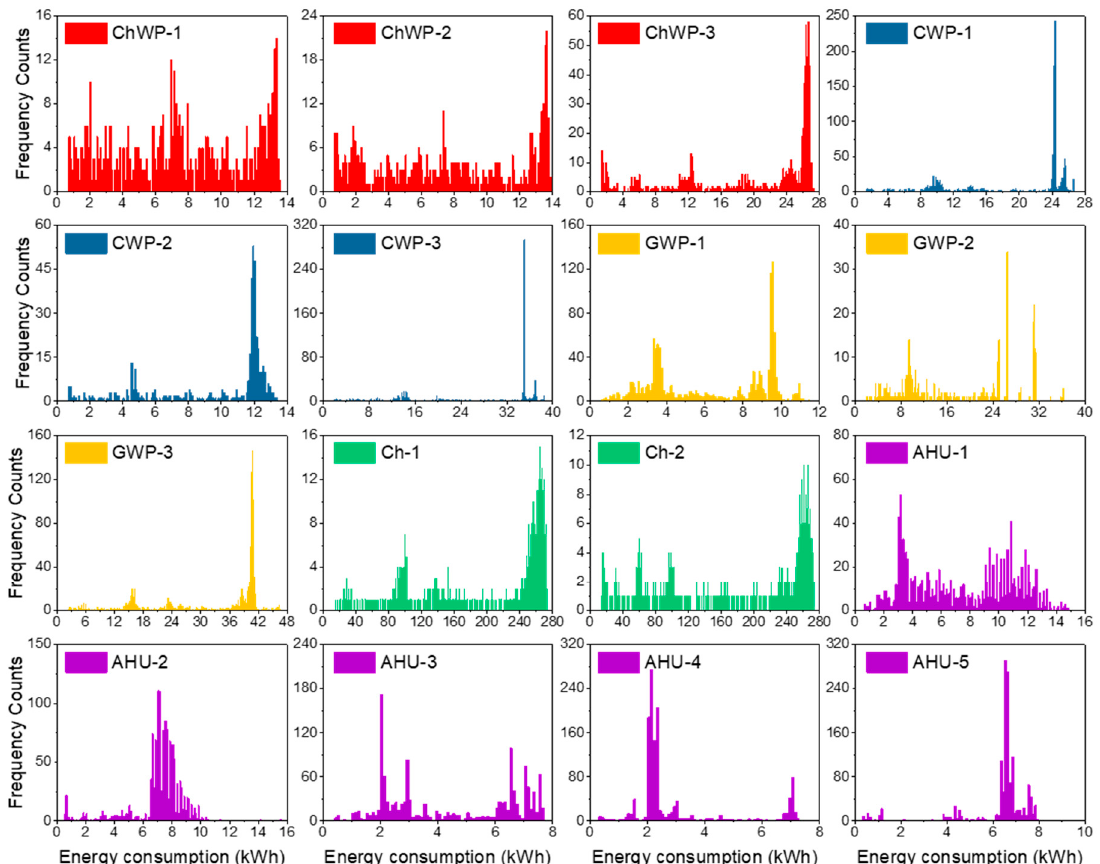
Figure 2. Energy consumption data distributions of 16 motor-driven equipment (ME) items in the case study.